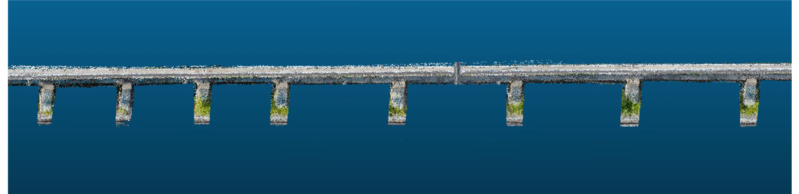
Figure 14. Illustration of the dense point clouds of the magnetic floating linear structure.